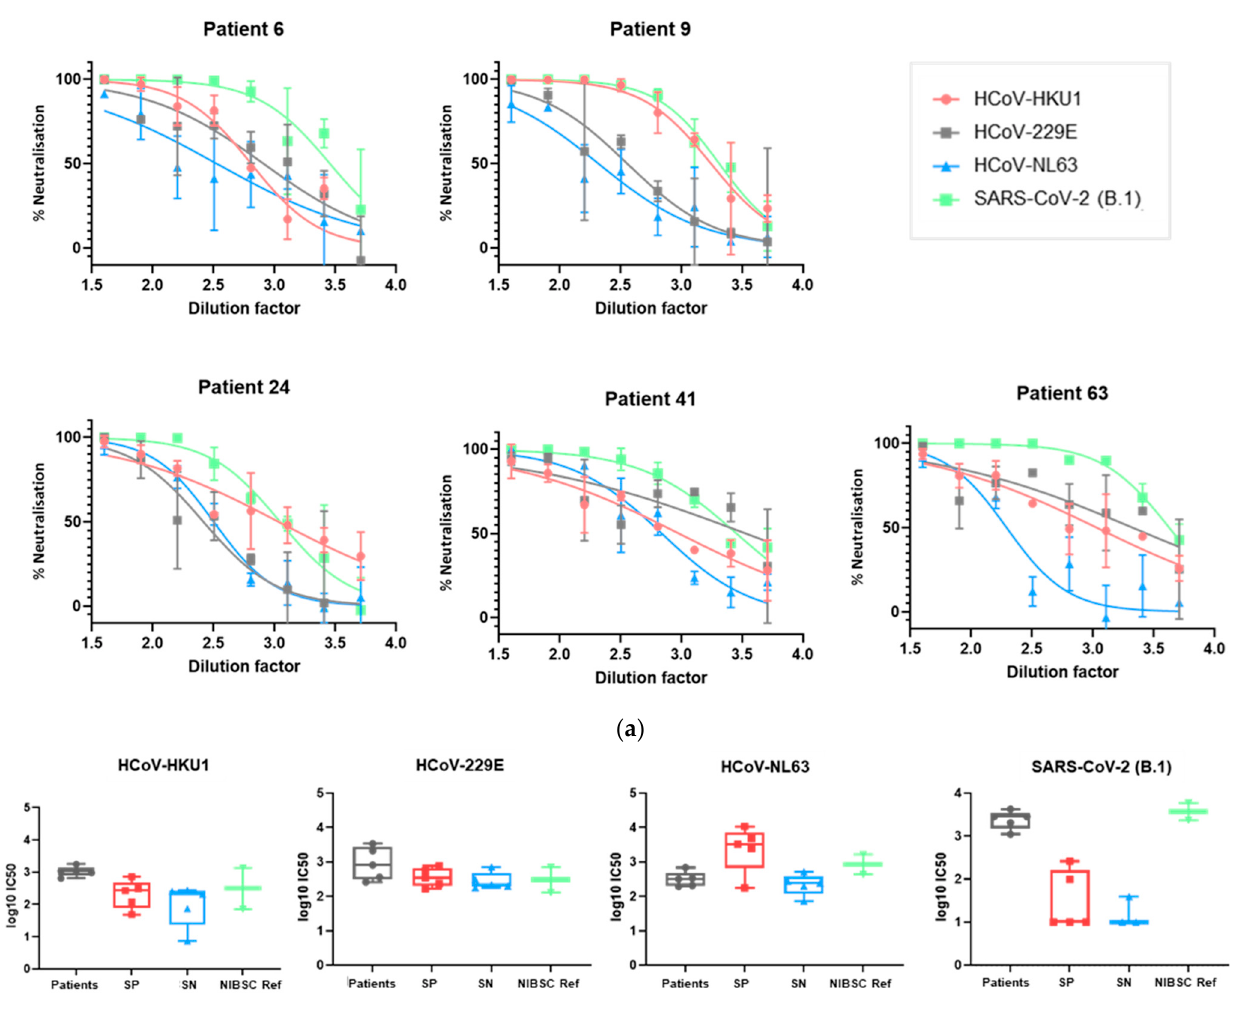
Figure 9. Neutralization of SARS-CoV-2, HCoV-NL63, HCoV-229E and HCoV-HKU1 by serum samples from 5 SARS- CoV-2 seropositive individuals (SP), 5 SARS-CoV-2 seronegative individuals (SN), 5 COVID-19 patients (patients) and 2 SARS-CoV-2 seropositive NIBSC reference sera (NISBC ref); ( a ) neutralization of SARS-CoV-2, HCoV-HKU1, HCoV-229E and HCoV-NL63 by 5 COVID-19 patient serum samples. Further neutralization curves by additional serum samples are shown in Supplementary Figure S1. Curves fit by non-linear regression using GraphPad Prism 9; ( b ) IC50 values compared between each group of serum samples for each PV. IC50 values were calculated using GraphPad Prism 9 as the dilution of sera needed for 50% neutralization of luciferase output/PV entry.